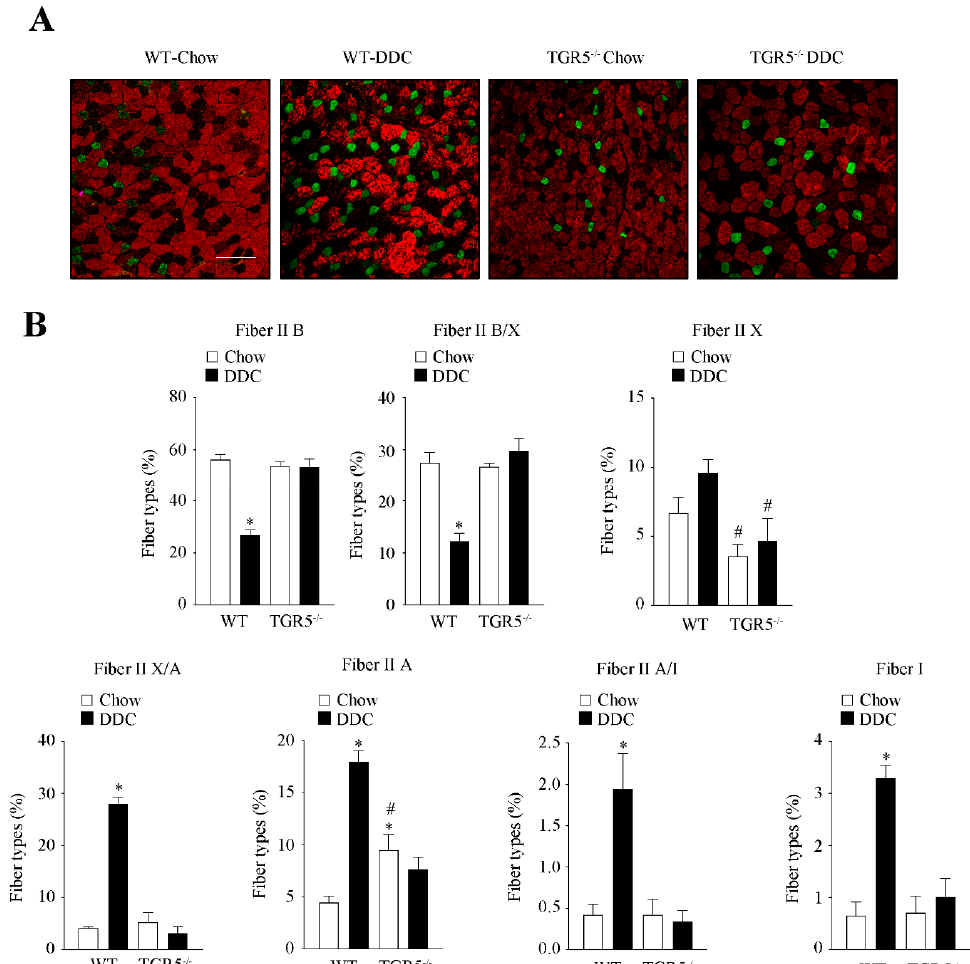
Figure 4. The fast-to-slow transition in muscle fiber type induced by CLD is dependent on TGR5 expression. The TA muscle was obtained from C57BL/6J male WT and TGR5 -/- mice fed with a standard (chow) or DDC-supplemented diet for 6 weeks. ( A ) The fiber types were determined by indirect immunofluorescence detection of MHC isoforms (IIA, IIB, I). Fluorescent images reveal the fiber composition in a whole muscle/cross-section: red (IIB), green (IIA), blue (I), not stained (IIX), and mixed: IIB/IIX, IIA/IIX, IIA/I. The scale bar corresponds to 150 µm. ( B ) The abundance of the different fiber types in the experimental groups (WT-chow, WT-DDC, TGR5 -/- -chow, and TGR5 -/- -DDC) is shown in the graphs. The values represent the mean ± SEM ( n = 3, * p < 0.05 vs. chow, # p < 0.05 vs. WT DDC, two-way ANOVA, Tukey’s multiple comparison test).